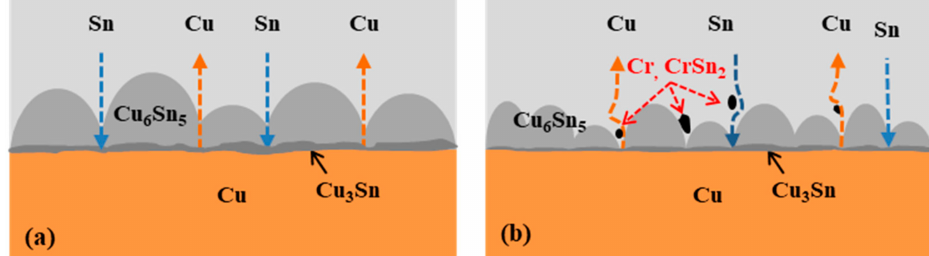
Figure 11. Schematic of the interdiffusion of Cu and Sn in the ( a ) Sn-0.7Cu/Cu and ( b ) Sn-0.7Cu- 0.2Cr/Cu systems.